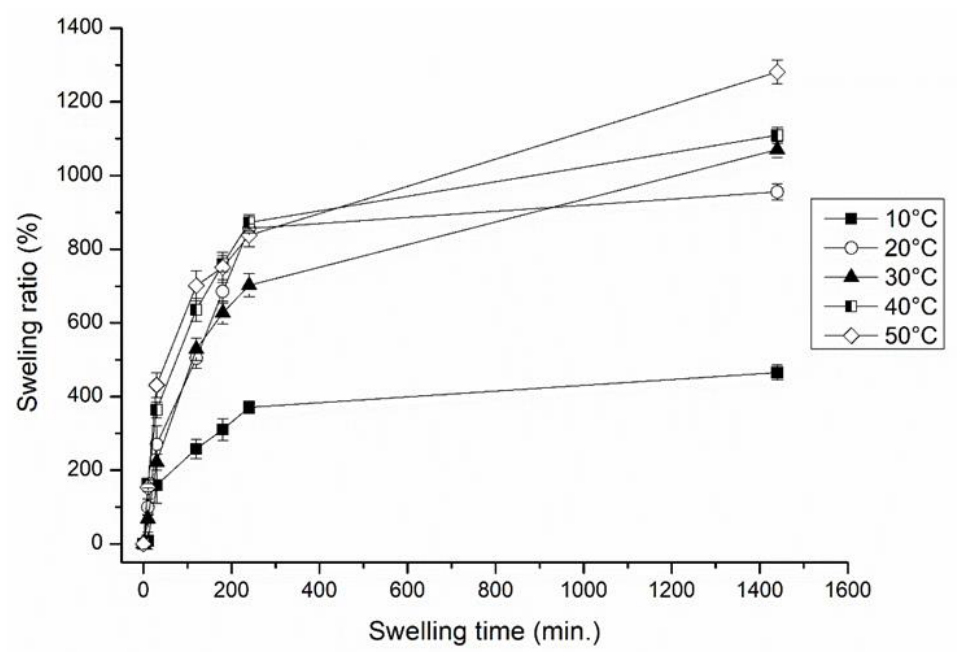
Figure 1. Swelling ratio (%) for hydrogel H5CA immersed in distilled water at different temperatures. The data comprise mean values for SR derived from three instances of water uptake (in weight ± SD; n = 3).